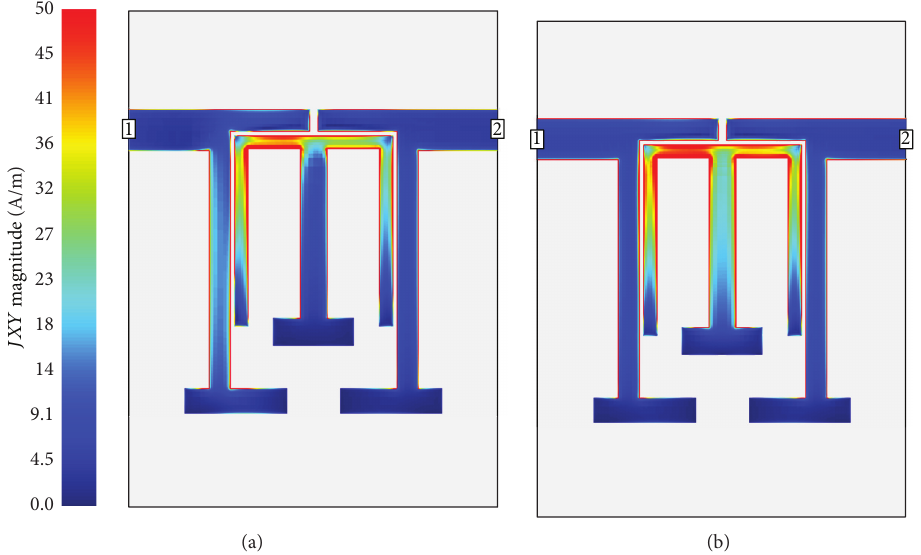
Figure 3: The current distribution in the proposed BPF at resonant frequency: (a) odd-mode and (b) even-mode.